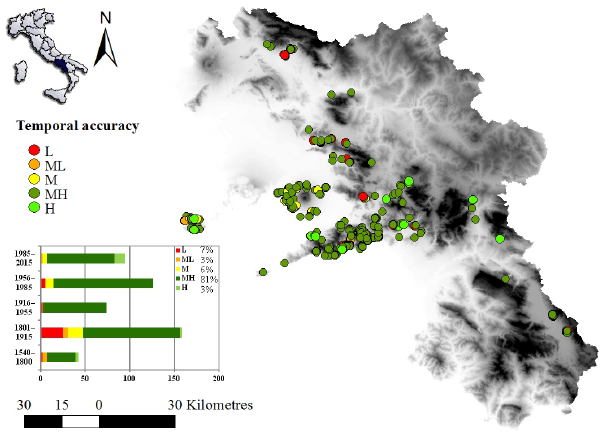
Figure 6. Temporal accuracy distribution of the events collected in Campania. The histogram shows the distribution in five classes of temporal accuracy: low (L), medium-low (ML), medium (M), medium-high (MH), and high (H). The histogram on the left shows the distribution of the accuracy classes in five temporal